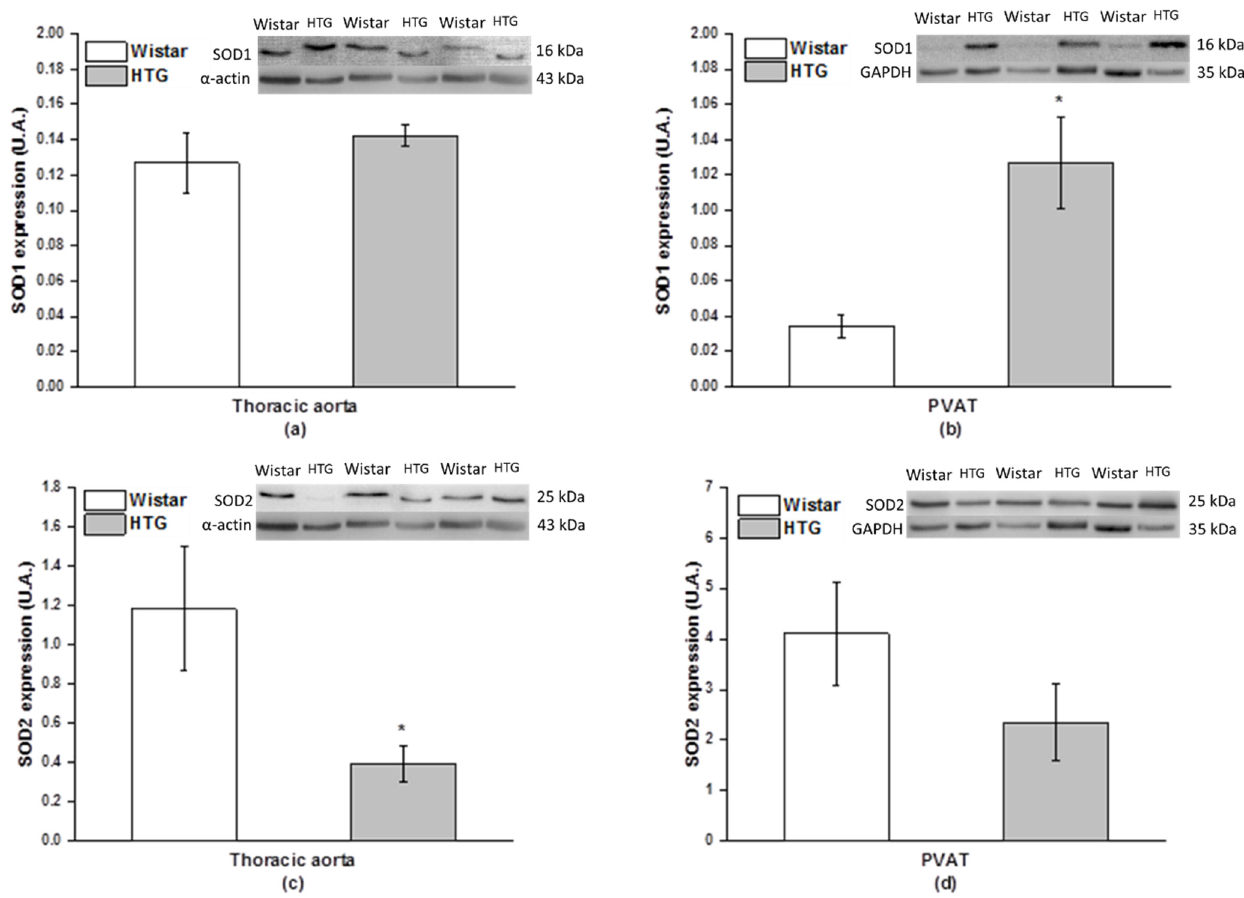
Figure 8. The protein expression of superoxide dismutase 1 (SOD1) in the aorta ( a ) and perivascular tissue (PVAT; b ) and superoxide dismutase 2 (SOD2) in the aorta ( c ) and perivascular tissue ( d ) in Wistar rats (n = 7) and hypertriglyceridemic rats (HTG, n = 8). The results are presented as the mean ± S.E.M., and differences between groups were analyzed by one-way ANOVA with the Bonferroni post hoc test. * p < 0.05 vs. HTG.